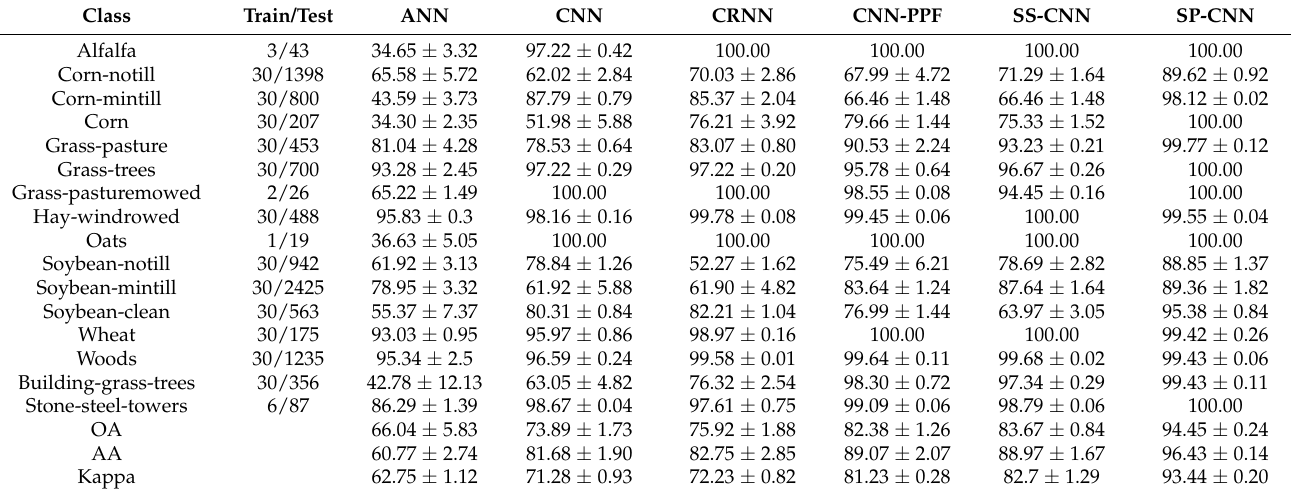
Table 2. Classification accuracy (%) achieved by seven different methods on Indian Pines